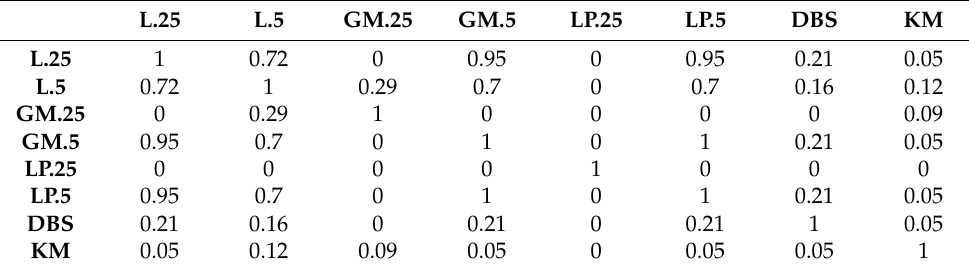
Table 7. NMI index for wholesale customers